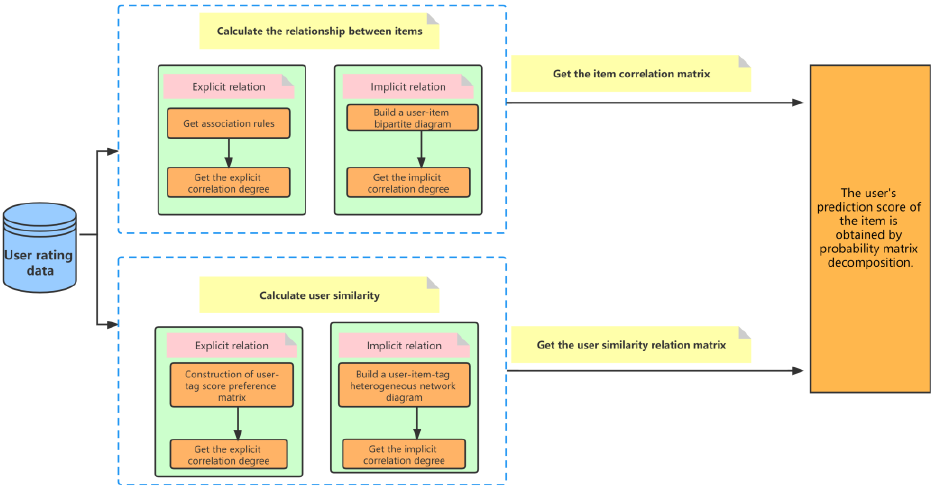
Figure 3. IC-US-PMF recommended model frame diagram. The model is divided into two parts, the first step is to get the user similarity matrix and the item correlation matrix, and the second step is to get the score of the target item by the target user according to the probability decomposition model.